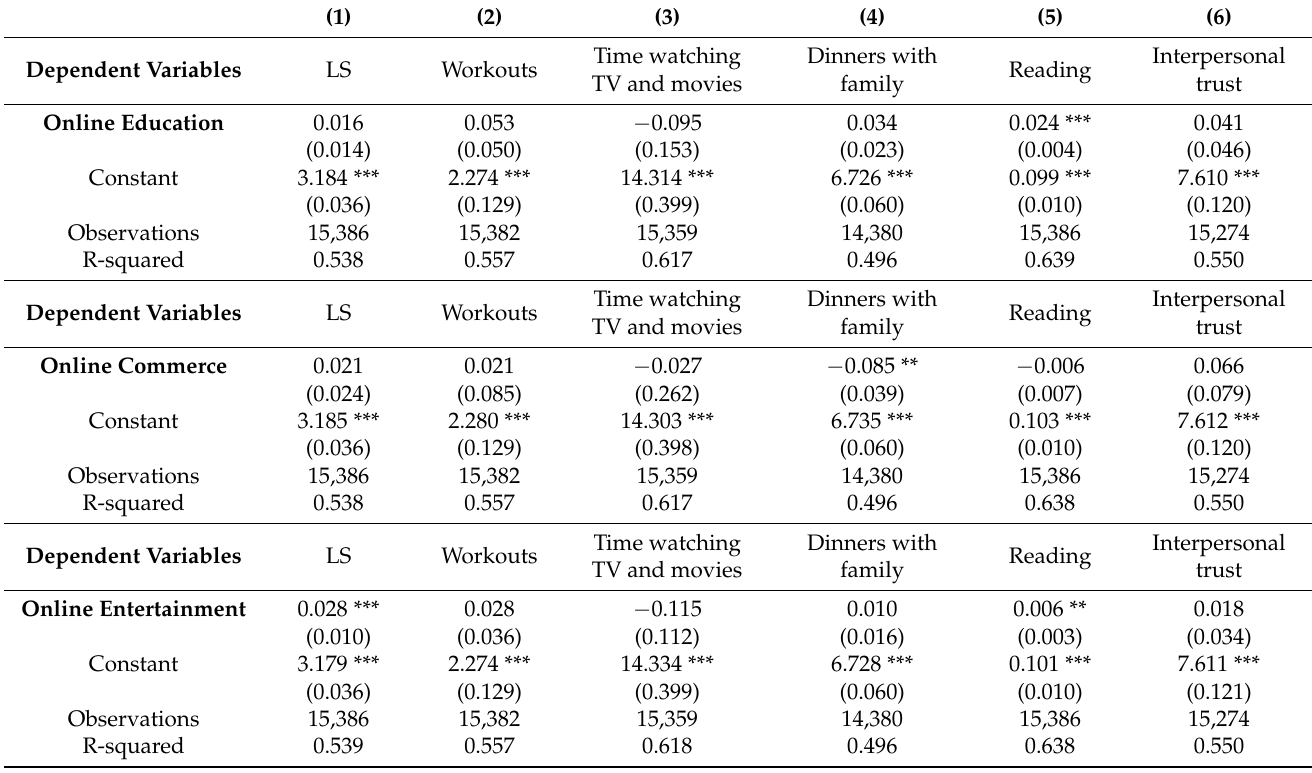
Table 4. Different online activities and the LS of older